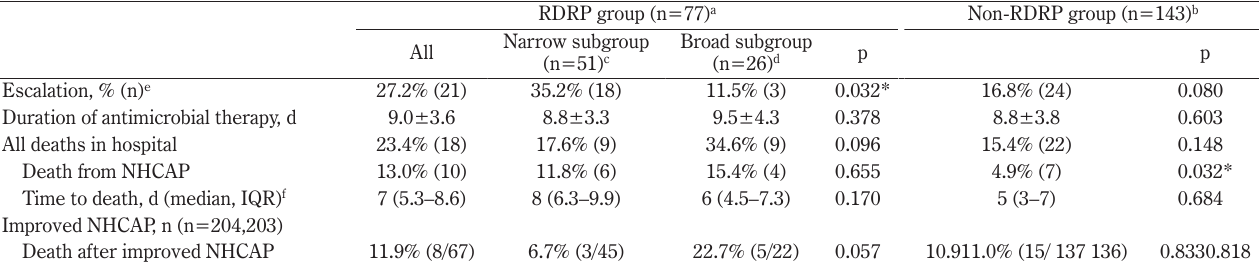
Table 2 Characteristics of patients with in-hospital